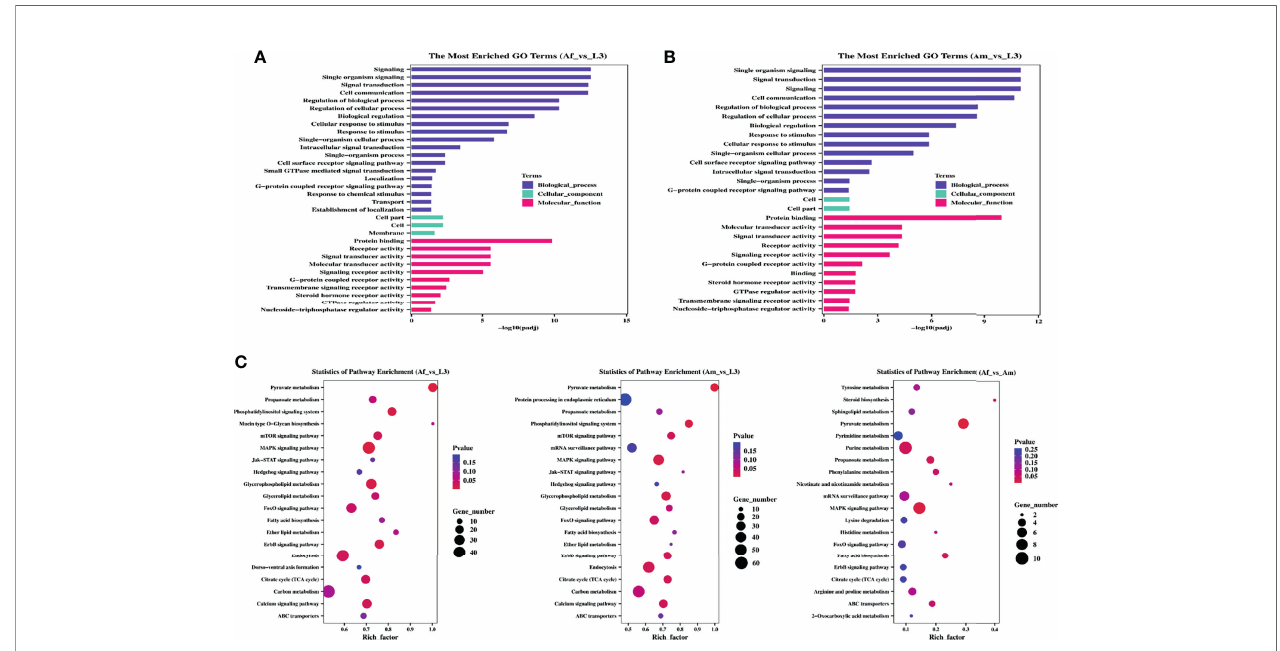
FIGURE 3 | GO and KEGG enrichment analysis for differentially expressed circRNAs of H. contortus . (A, B) The most enriched GO terms in Af_vs_L3 and Am_vs_L3. Y-axis represented GO terms; X-axis represented the value of -log10 (padj). Different colors represented biological_process, cellular_component, and molecular_function, respectively. (C) The top 20 enriched KEGG pathways. Y-axis represents pathways; X-axis represents rich factor; The color and size of each bubble represent pvalue and the number of genes enriched in a pathway, respectively. Af_vs_L3, Am_vs_L3, and Af_vs_Am are represented from left to right.